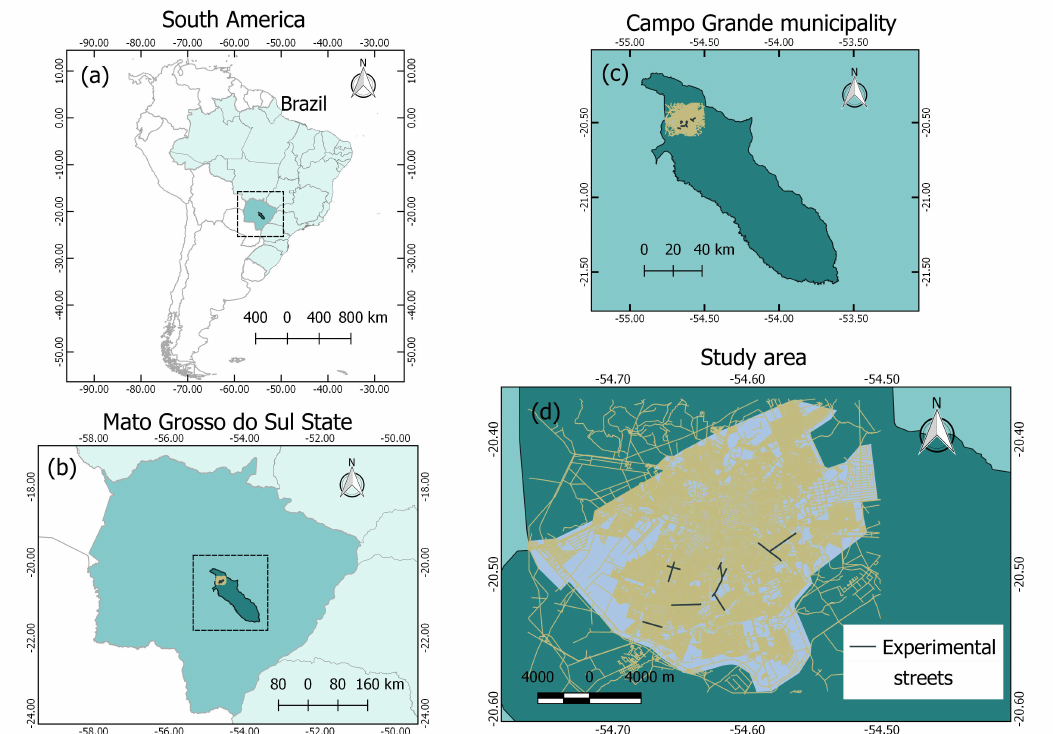
Figure 1. Study area in ( a ) South America and Brazil, ( b ) Mato Grosso do Sul, ( c ) Campo Grande, and ( d ) experimental streets. The black lines represent the streets used in the